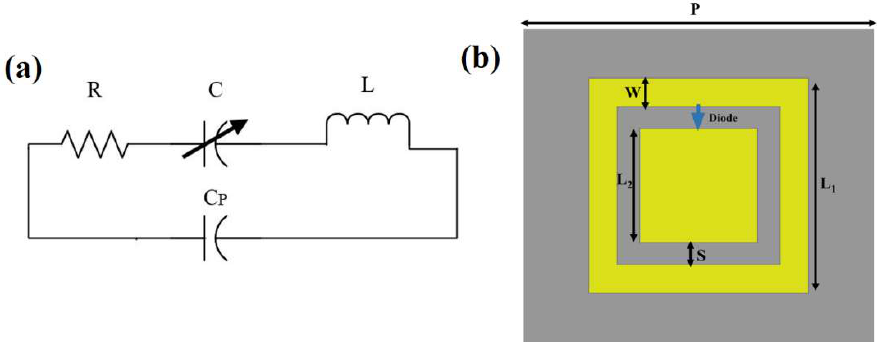
Figure 1. Design specification of the proposed MMA: ( a ) RLC equivalent circuit model of the varactor diode, and ( b ) schematic of the meta-unit cell of the proposed MMA .